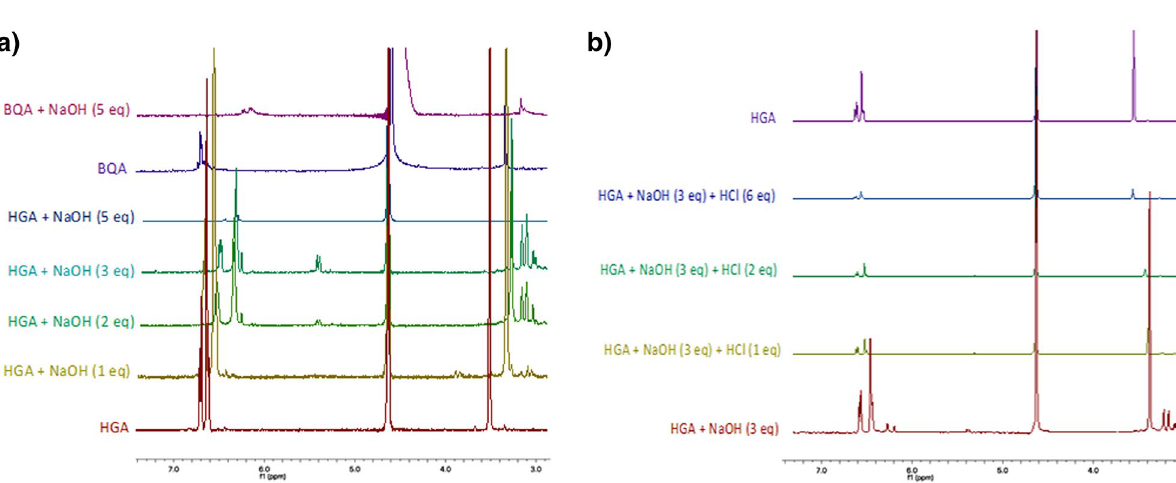
Figure 6. ( a ) 1 H-NMR BQA and HGA in D 2 O/H 2 O in the presence of different equivalents (1 to 5); ( b ) titration of HGA in NaOH solution by addition of different equivalents of HCl (1 to